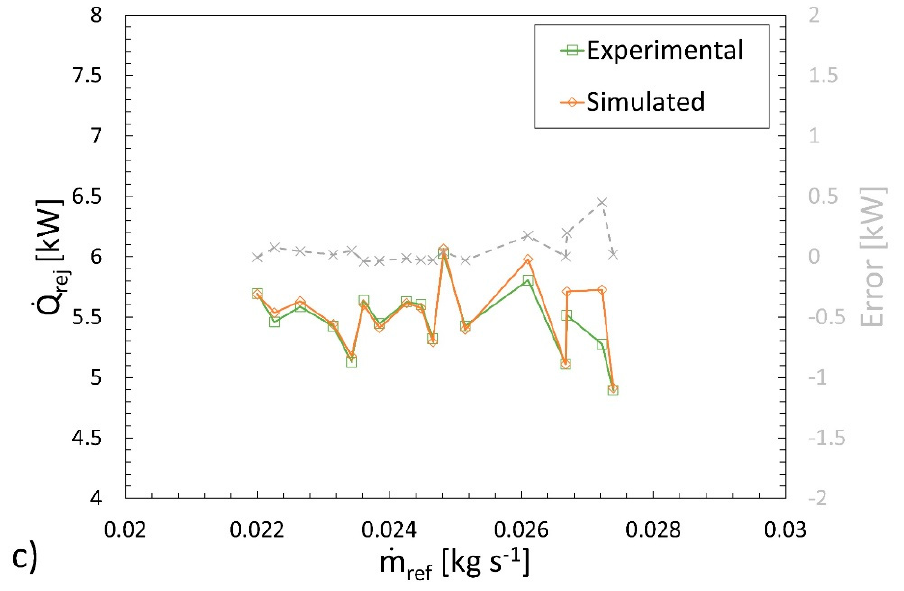
Figure 14. Comparison of the output of the model with the corresponding experimental values for different mass flow rate values under test conditions: ( a ) outlet refrigerant temperature, ( b ) outlet refrigerant pressure and ( c ) rejected heat. The error of the model is shown on the secondary y -axis and represented by the gray line.